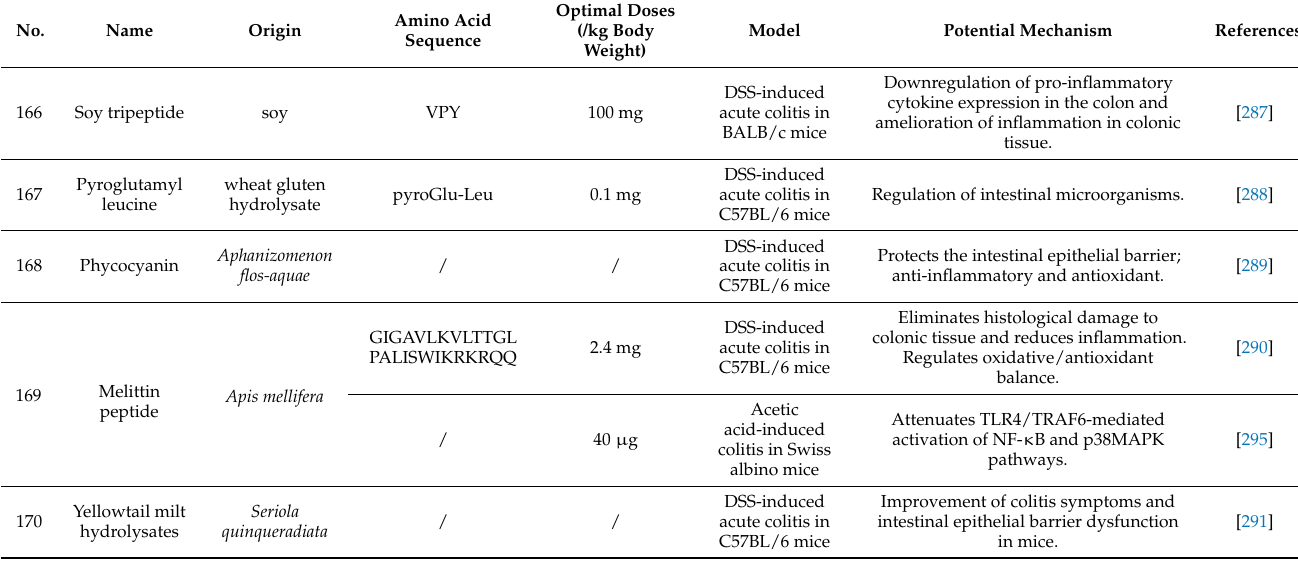
Table 9. Therapeutic effects of natural proteins and active peptides on experimental